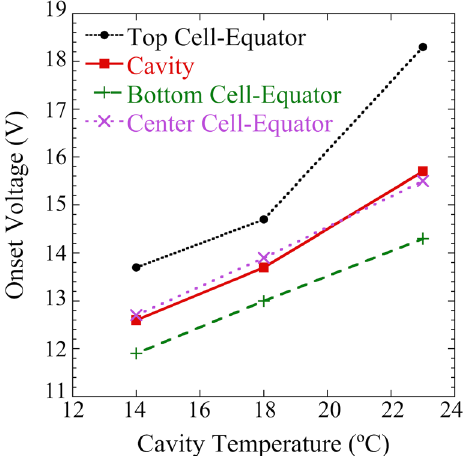
FIG. 18. Onset voltage, representing the minimum voltage at which the EP plateau appears, against the cavity surface temper- ature for the equator coupons and cavity. The tests were conducted with a cathode rotation of 20 rpm and optimized dual-flow condition.